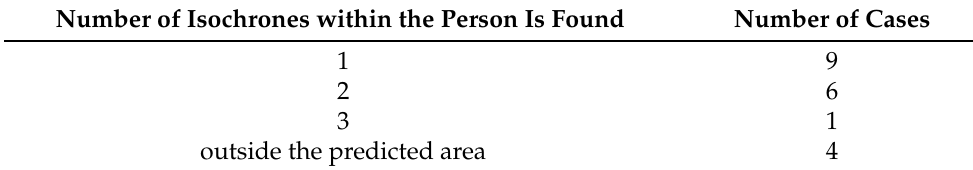
Table 4. Evaluation of the algorithm on real lost person SAR